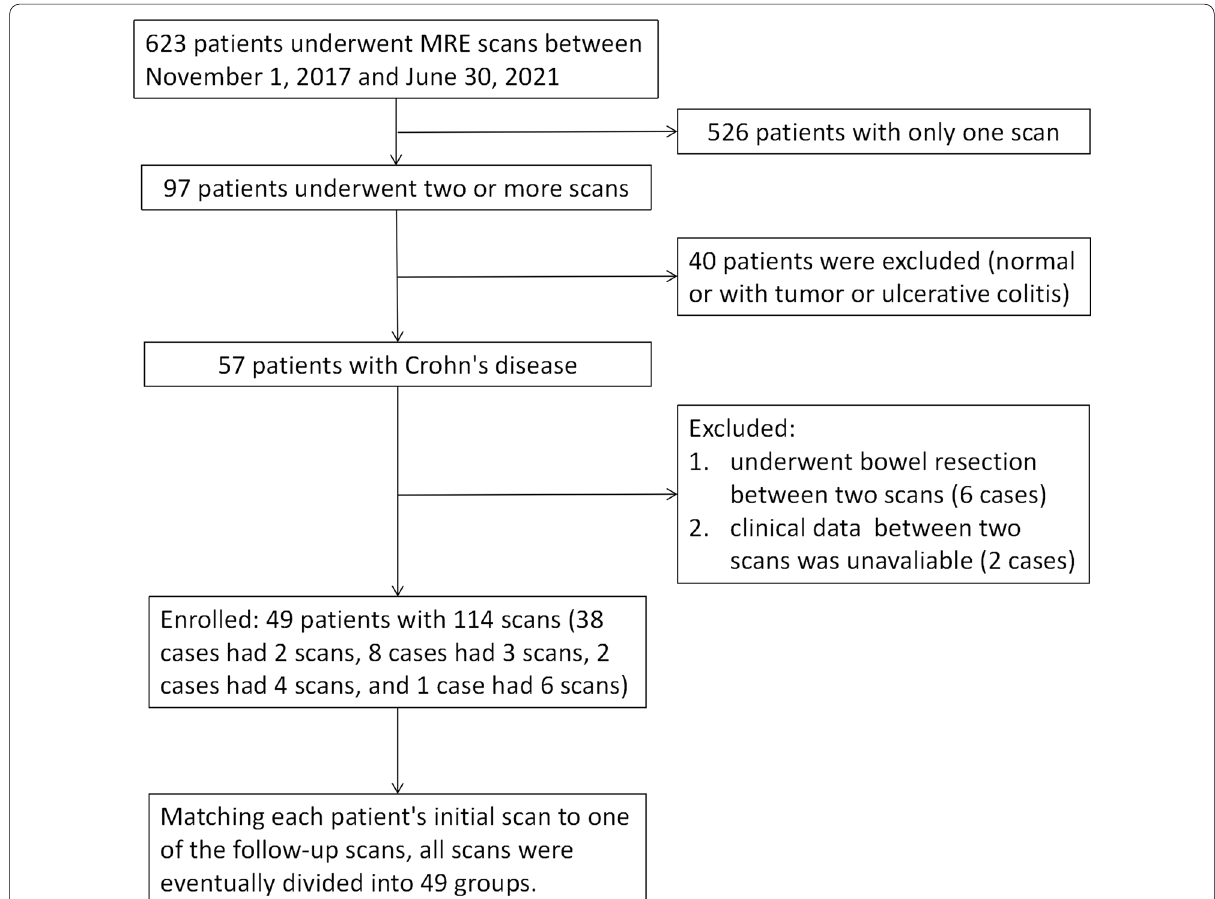
Fig. 2 Inclusion flowchart for Crohn’s disease